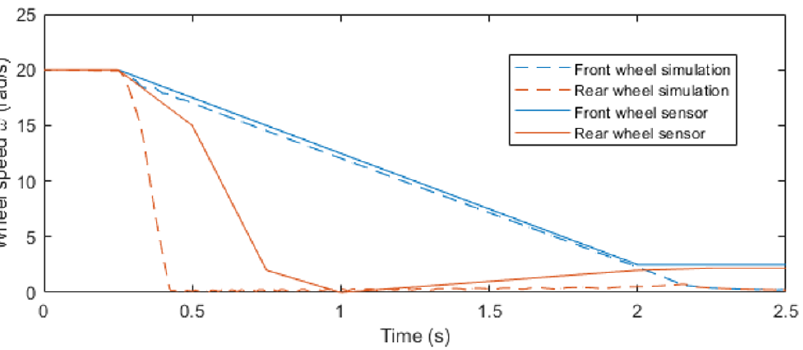
Figure 5. Comparison of wheel speed during a braking event for the simulation and for sensor data provided by Klug et al. [9]. Braking pressure was equal front and rear. The discrepancy at 0.5 s may indicate an incorrect simulation model or research data.